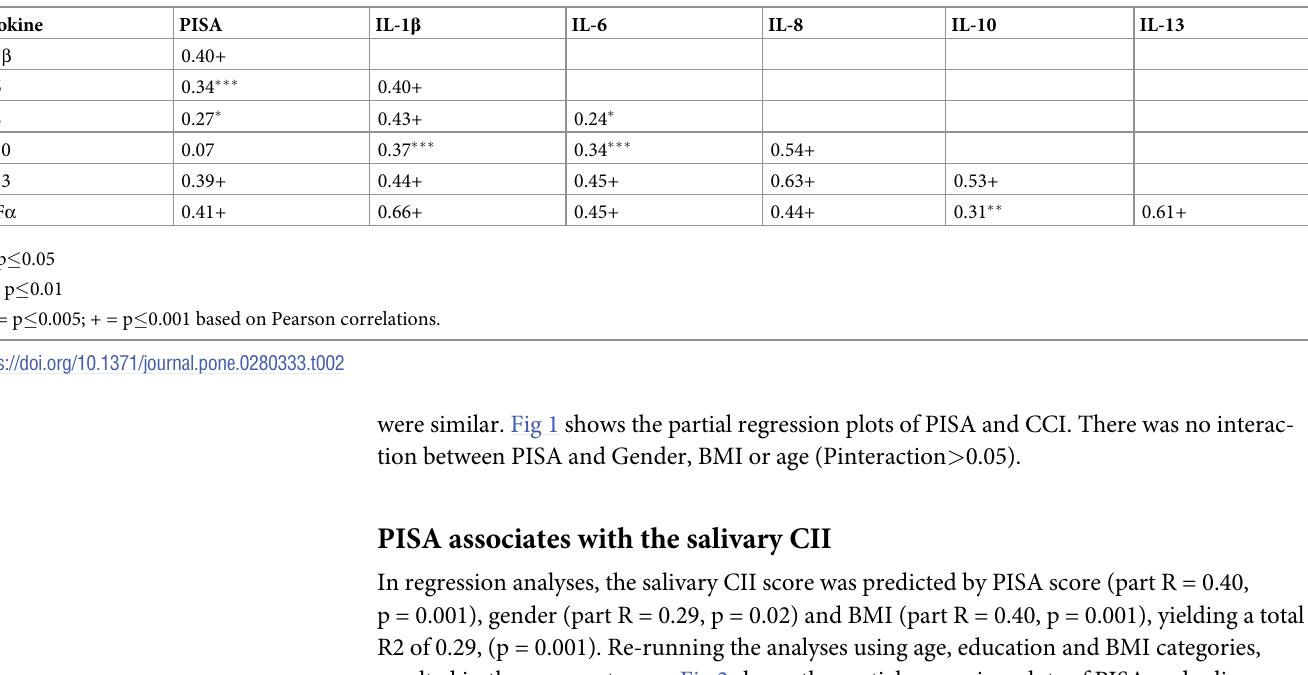
Table 2. Correlations between PISA and salivary cytokines (log).